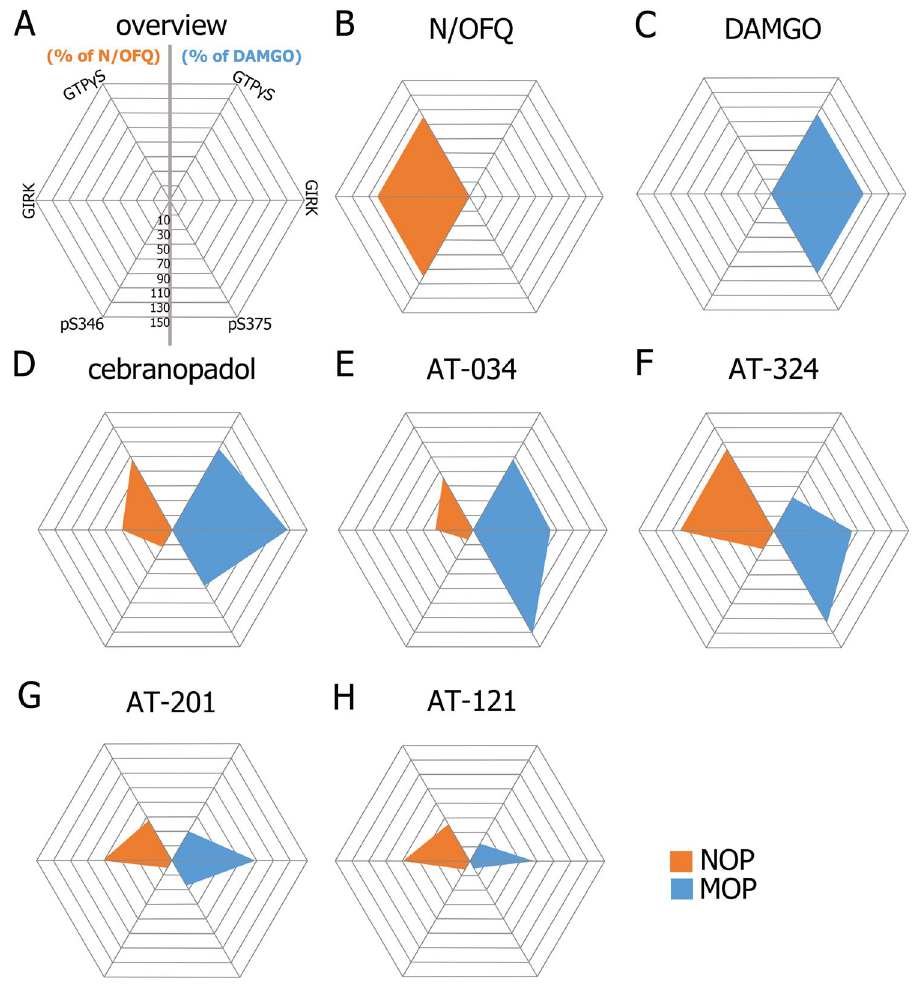
Figure 5. Radar graphs illustrating the balance between agonist-mediated effects of the investigated compounds at NOP (orange) and MOP (blue). All axes represent values normalized to maximal concentration of N/OFQ or DAMGO set at 100%. Phosphorylation values were calculated for the primary phosphorylation site S346 at NOP and S375 at MOP. Scale ranging from − 10 to 150% with an interval of